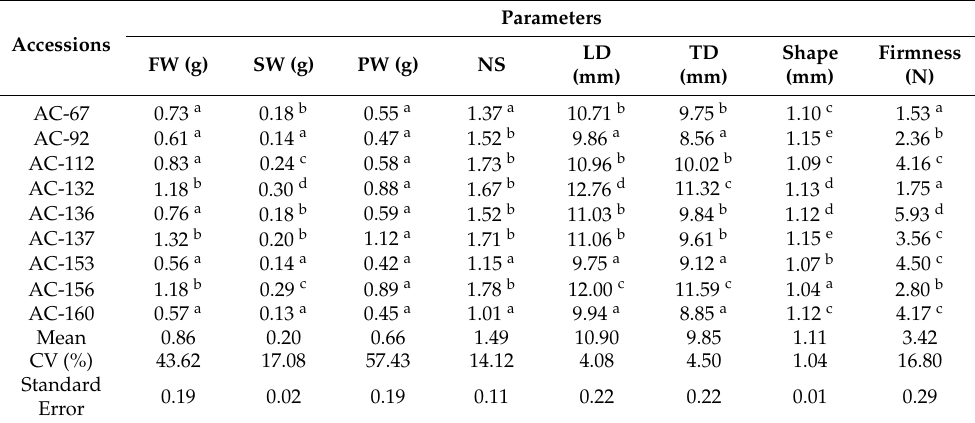
Table 1. Physical characteristics of fruits of nine accessions of Myrciaria floribunda , differentiated by their orange, red, and purple